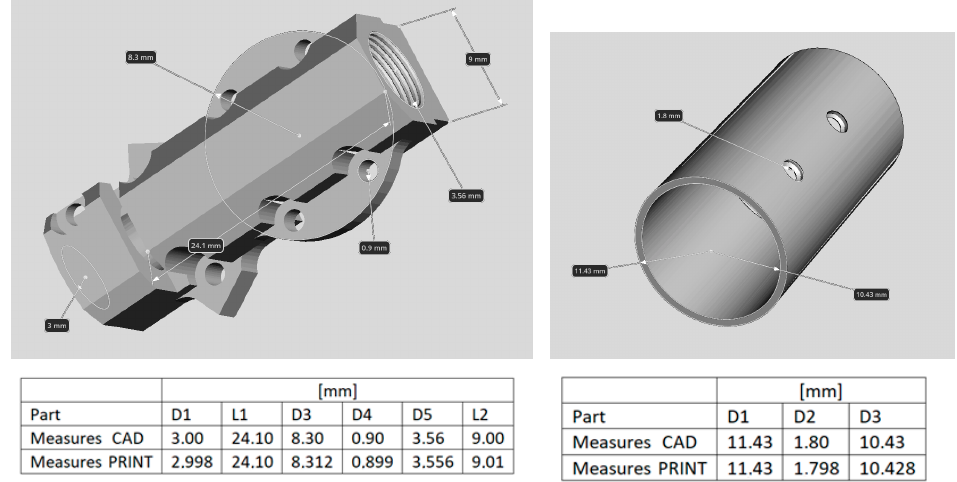
Figure 24. Statistics of the printed parts’ dimensions.